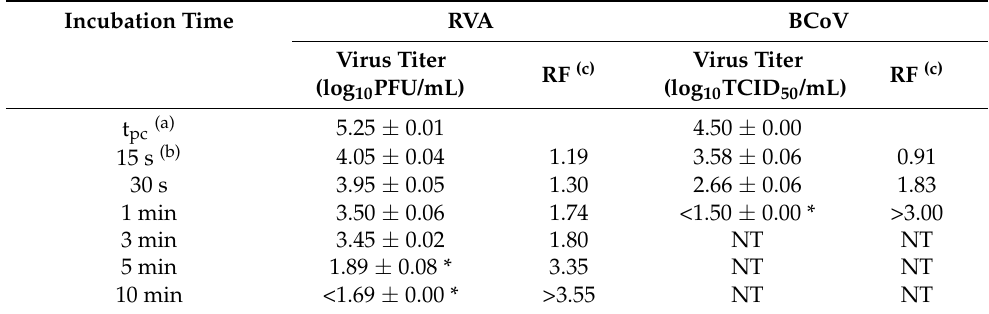
Table 3. Virucidal efficacy of the Mix500 toward bovine rotavirus A (RVA) and bovine coronavirus (BCoV) in rubber